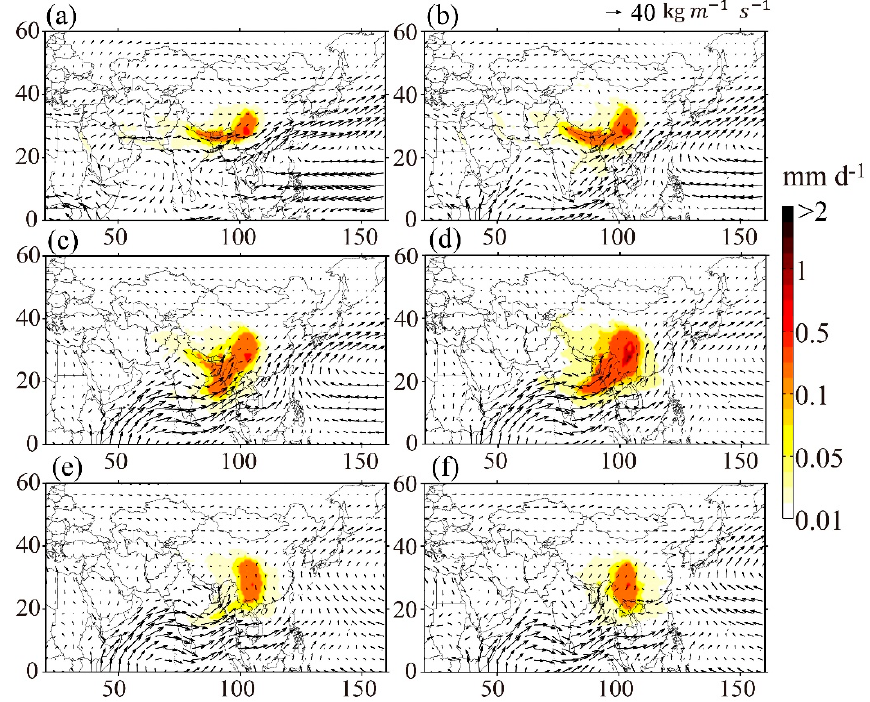
Figure 7. Monthly mean common evaporative sources change larger than 0.01mm d − 1 (shades) for both target regions, and monthly integrated moisture fluxes (unit: kg m − 1 s − 1 ) from surface to 50 hPa (arrows) in the wet season ( a ) April, ( b ) May, ( c ) June, ( d ) July, ( e ) August, ( f ) September over 1982– 2011.